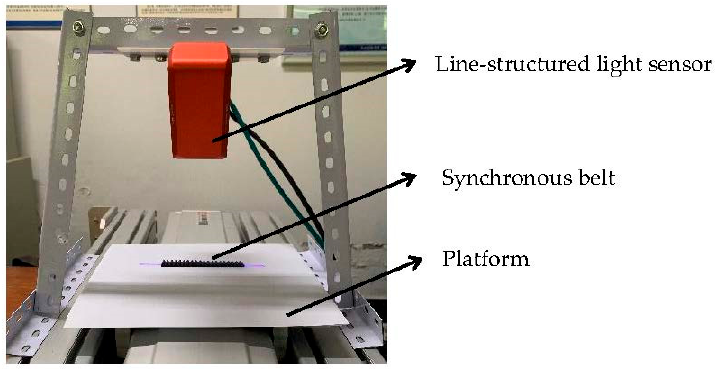
Figure 12. Synchronous belt tooth profile measurement system